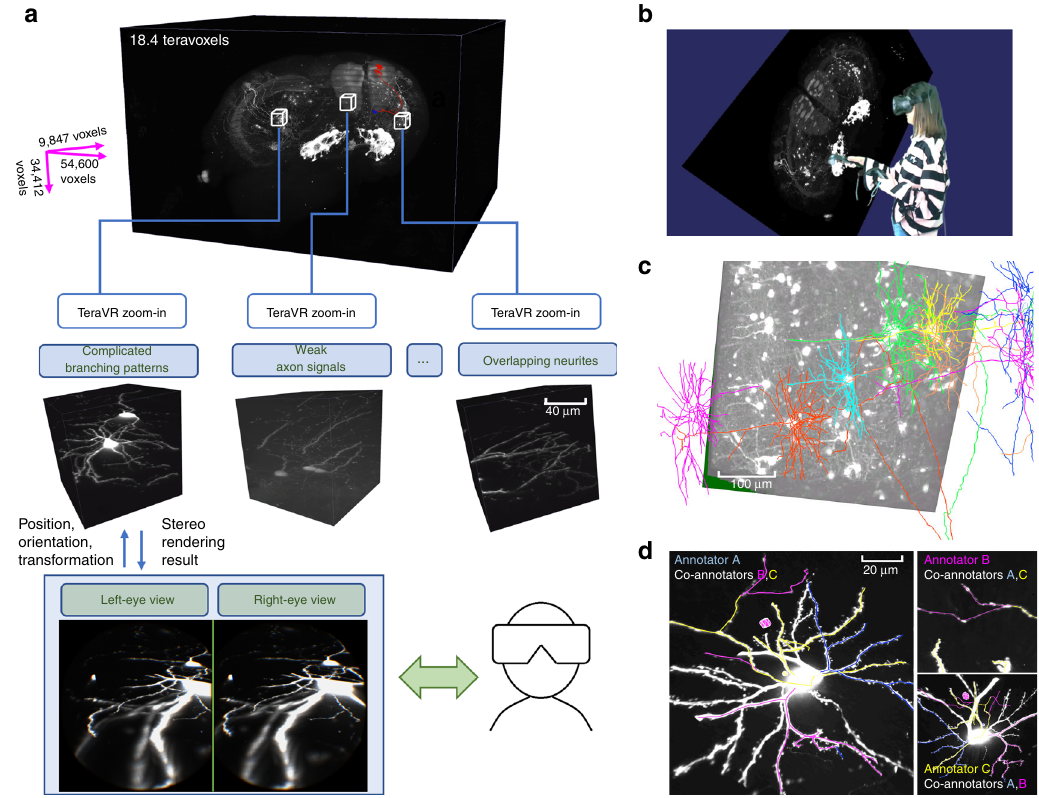
Fig. 1 The overall scheme of TeraVR. a TeraVR is applicable to very challenging visualization and reconstruction scenarios such as complicated branching, weak signals, and overlapping neurites. With TeraVR, a user is able to combine stereoviews to observe the complex 3-D neurite patterns easily and perform the reconstruction effectively. Combining such visualization and data-exploration functions with terabyte-scale imaging data (e.g., whole-brain scale) management and streaming capability enables reconstruction of complex neuronal morphology at an optimized accuracy and ef fi ciency. b A mixed reality visualization that demonstrates the use of TeraVR. Immersed in a virtual environment, the user manipulates the imaging data with TeraVR in a way similar to manipulating a physical object. c Multiple densely packed neurons (one in a different color) from an image with high, noisy background intensity level were reconstructed using TeraVR. d Real-time collaboration is demonstrated by showing views from all participating annotators. Each annotator logs onto the cloud and adopts a unique color for both annotation and an avatar representing the user ’ s real-time location. The left subpanel shows the view for annotator A (blue), in which two avatars of co-annotator B (purple) and C (yellow) are seen. Annotation results are instantly shared among them. The upper right subpanel: annotator B examined a partially traced segment by co-annotator C, only to identify more branches after turning up the contrast and having a close-up view of the segment (without affecting the views of other annotators); bottom right subpanel: the view of annotator